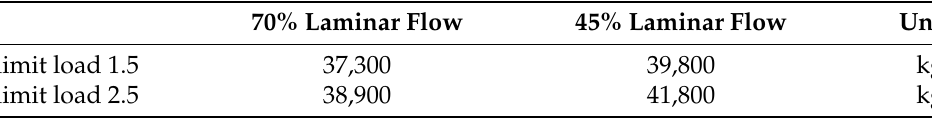
Table 11. MTOM values for the airframe weight reduction of 19%.